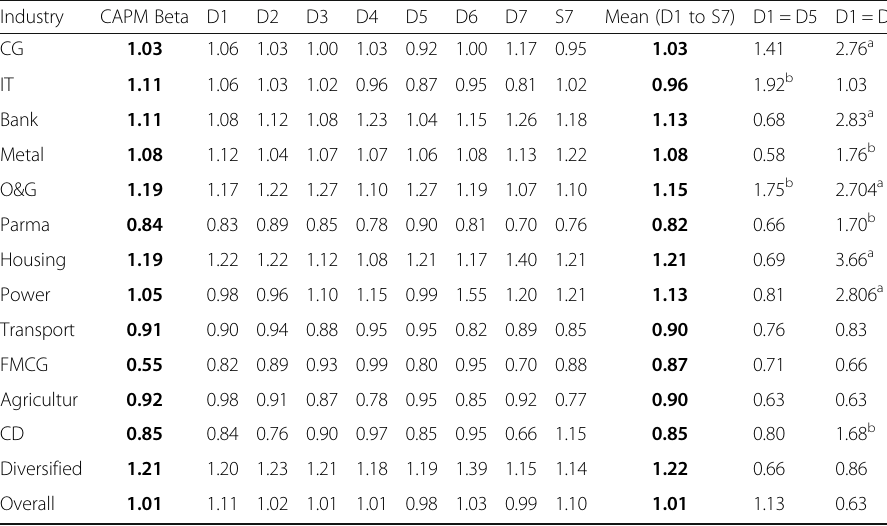
Table 5 Wavelet betas for Small Cap stocks